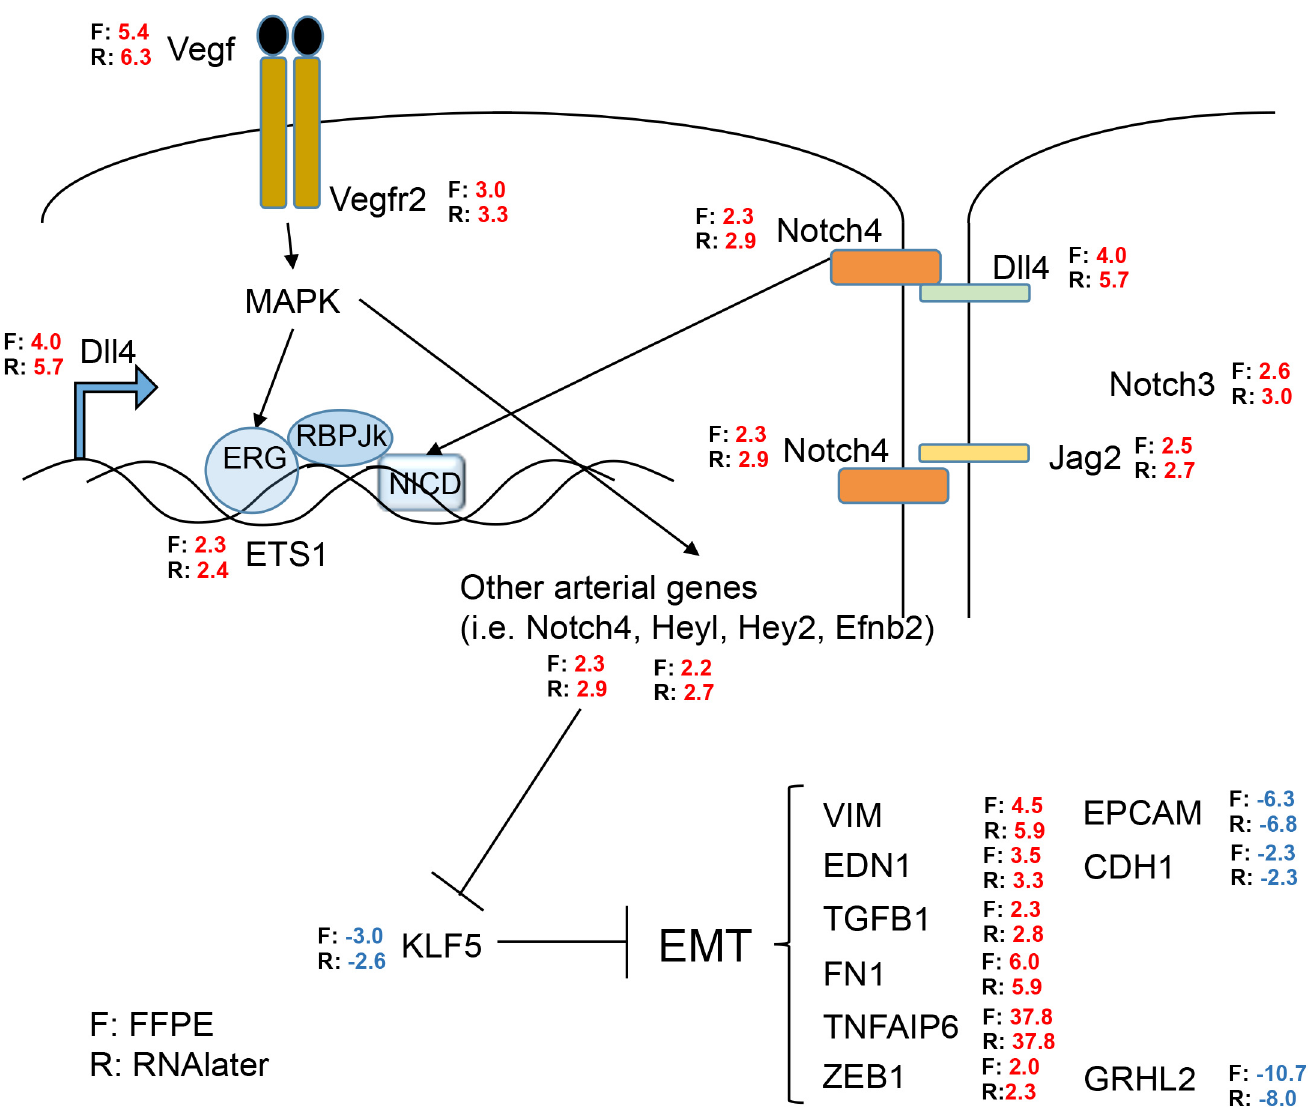
Fig 4. Pathway signature of VEGF and NOTCH mediated EMT in ccRCC. Comparison of gene expression data from the FFPE and from the RNAlater 1